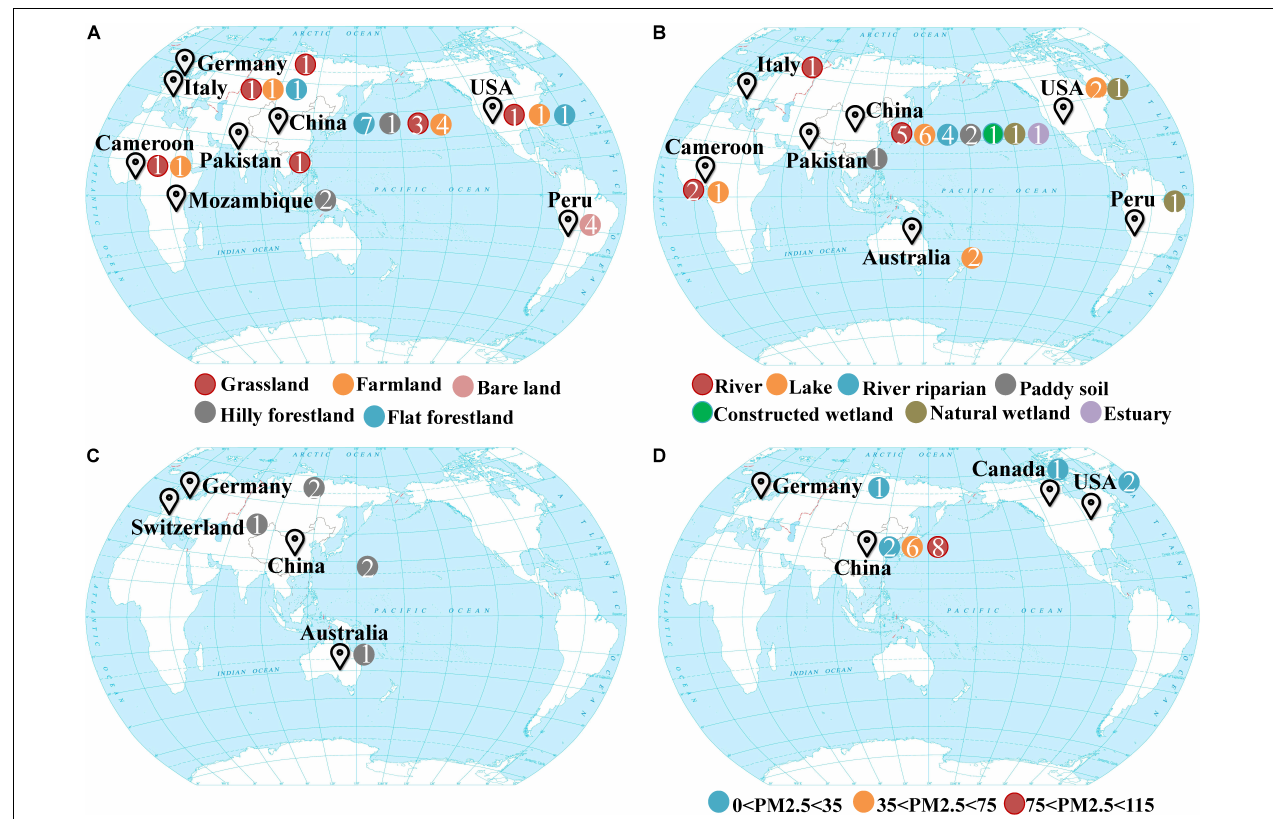
FIGURE 1 | Global maps showing the sampling sites of four different ecosystems (A) drylands, (B) wetlands, (C) groundwater aquifers, (D) snow. Colors indicate various habitats where samples were taken from, and n indicates the sample number.